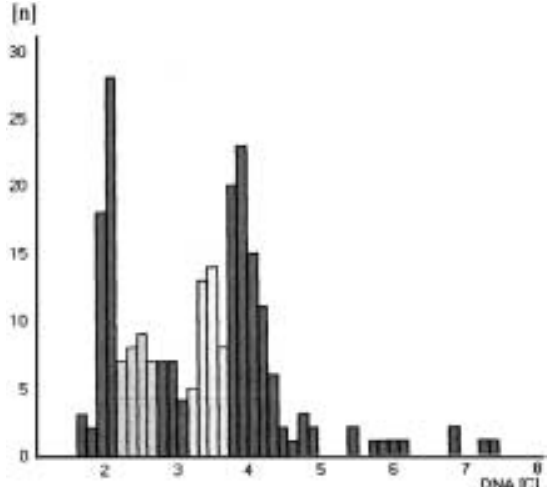
Fig. 10. DNA-histogram of a smear from a squamous cell carcinoma of the buccal mucosa (patient D). One aspect of DNA-aneuploidy can be detected: abnormal stemlines at 2.5c, 3.38c, 3c and